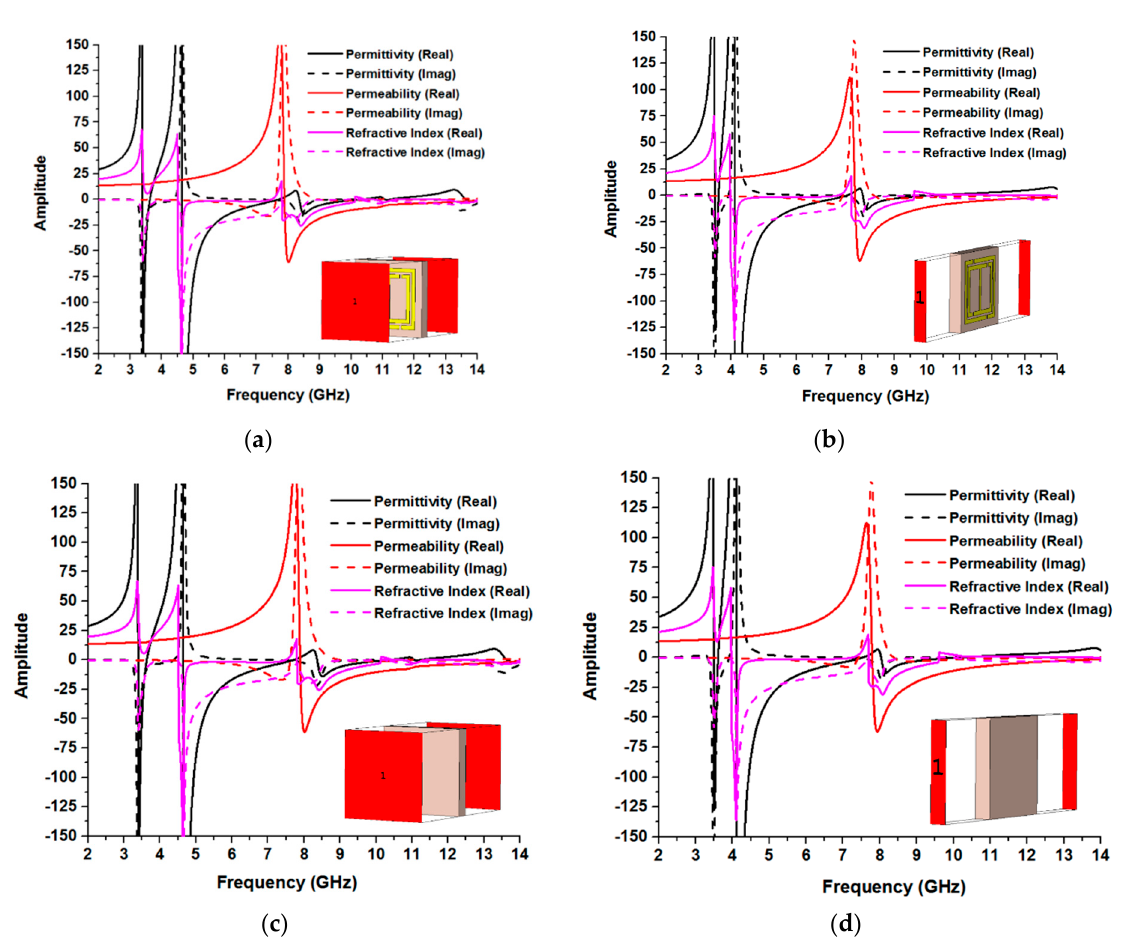
Figure 9. Amplitude of the permittivity, permeability and refractive index at: ( a ) 0°, ( b ) 90°, ( c ) 180°, ( d ) 270° rotations.